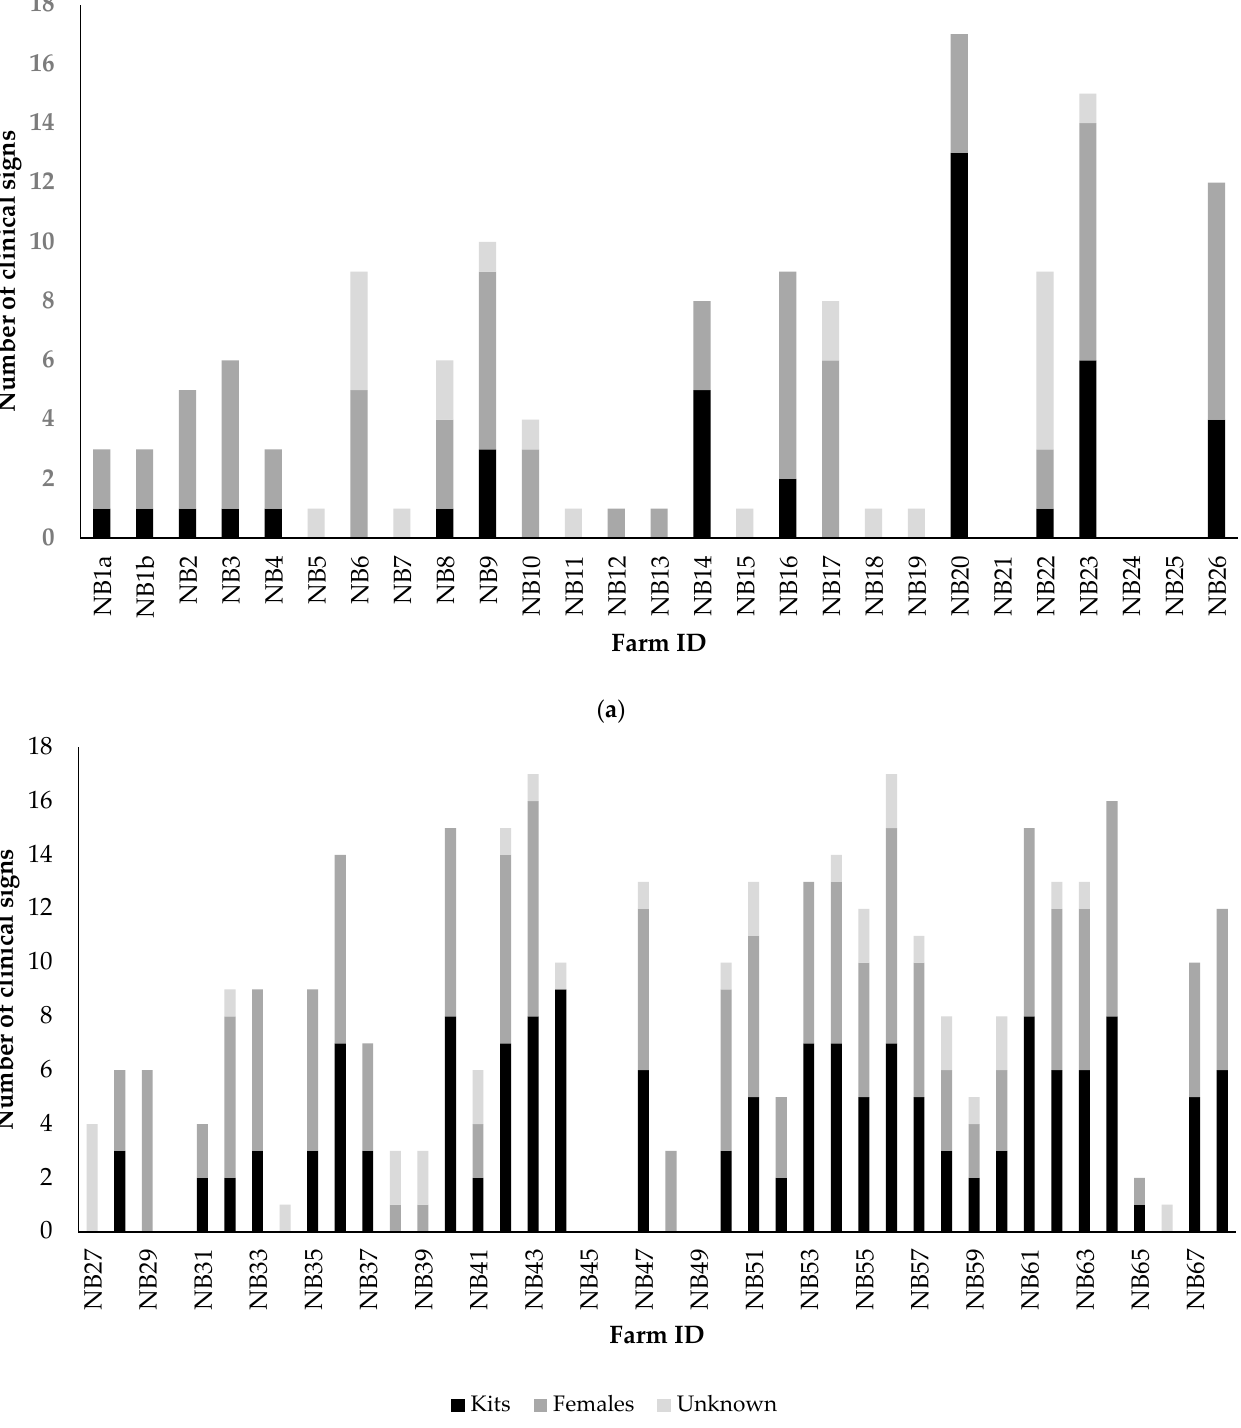
Figure 2. The total number of clinical signs observed on the SARS-CoV-2 infected mink farms in kits, female adults or in minks of unknown sex or age category, in case this information could not be found in the available records. The X-axis shows the farm-ID which consists of NB (abbreviation for Dutch word for mink farm) followed by a consecutive number according to the time of diagnosis. ( a ) NB1a-NB26, diagnosed between 31 May and 1 August; ( b ) NB27-NB68 diagnosed between 1